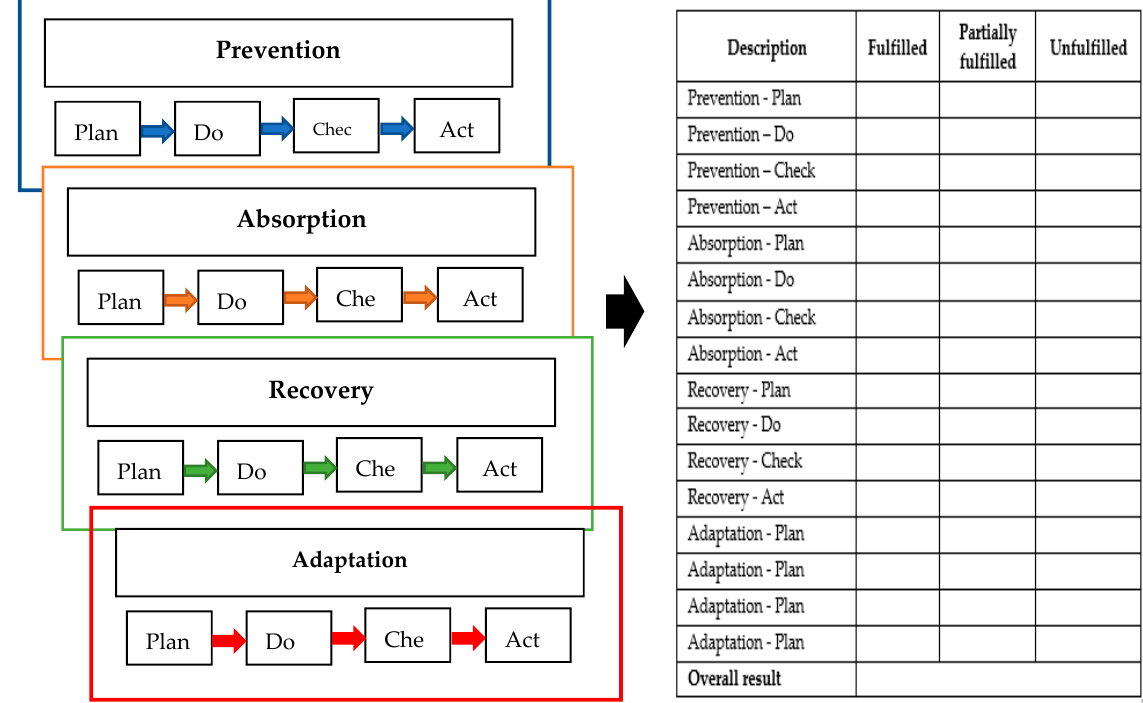
Figure 9. Demonstration of evaluation using checklists.